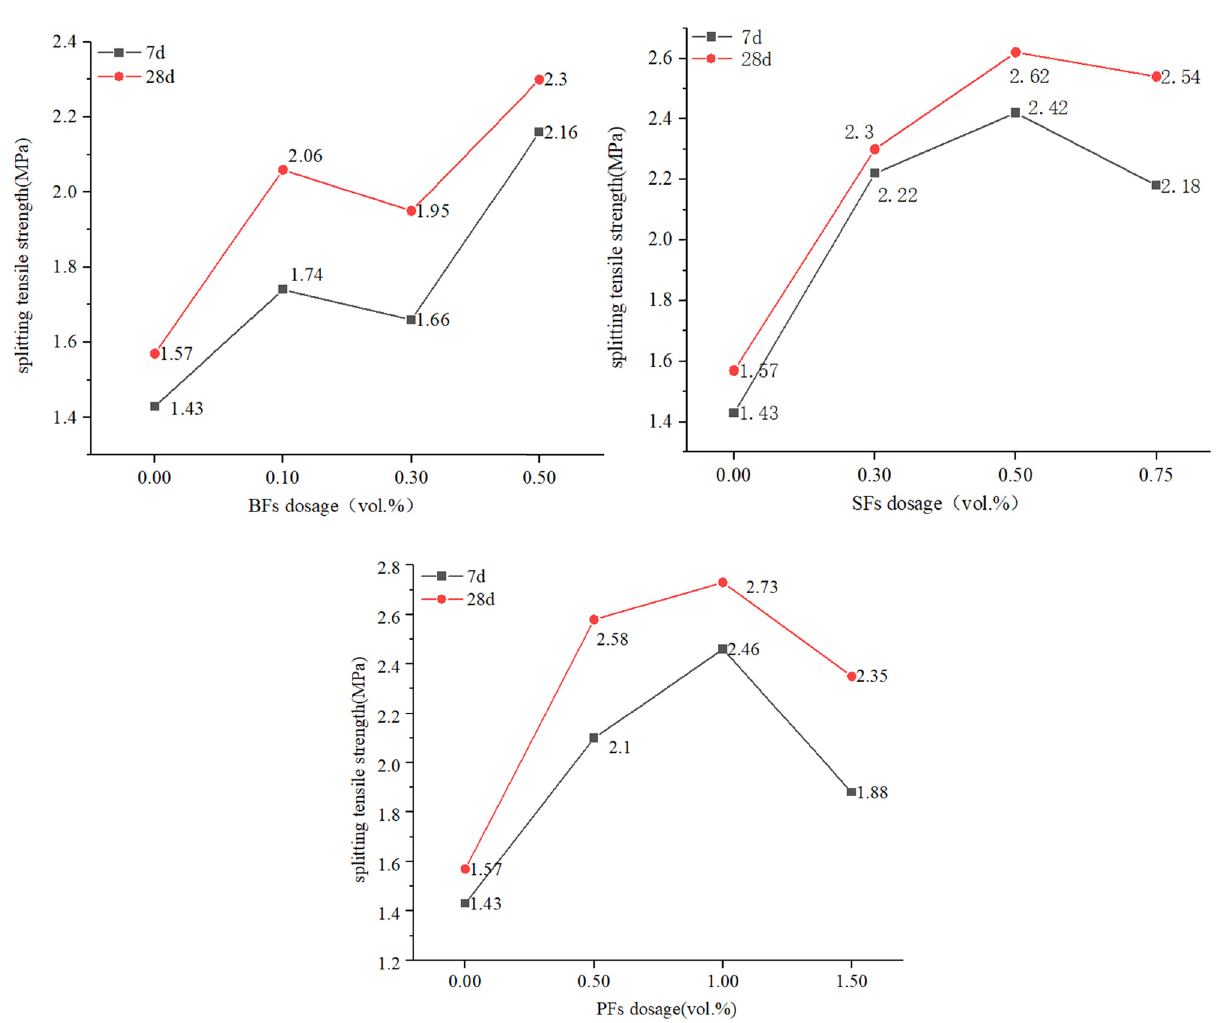
Figure 12: Splitting tensile strength of